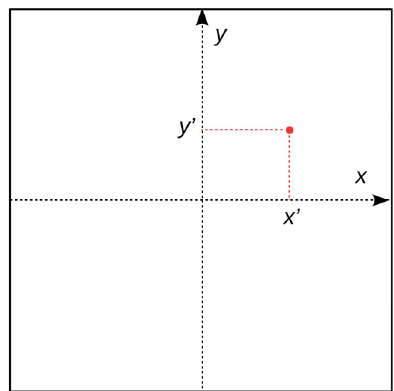
Figure 2. The subject of the analysis.